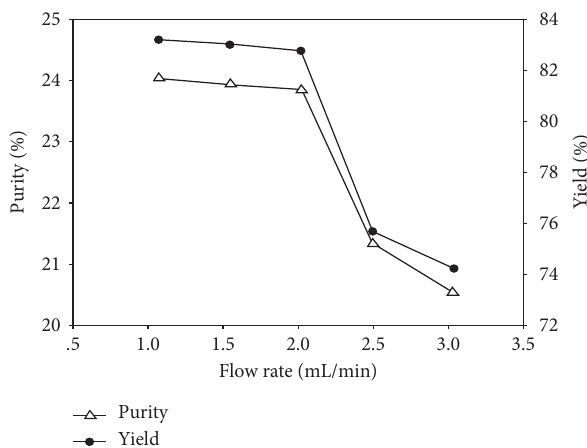
Figure 3: The effect of desorption flow rate on purification of